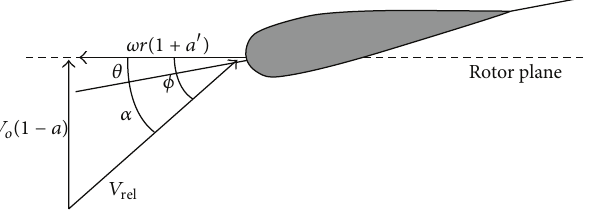
Figure 6: Velocities in the rotor plan of the wind turbine [22].